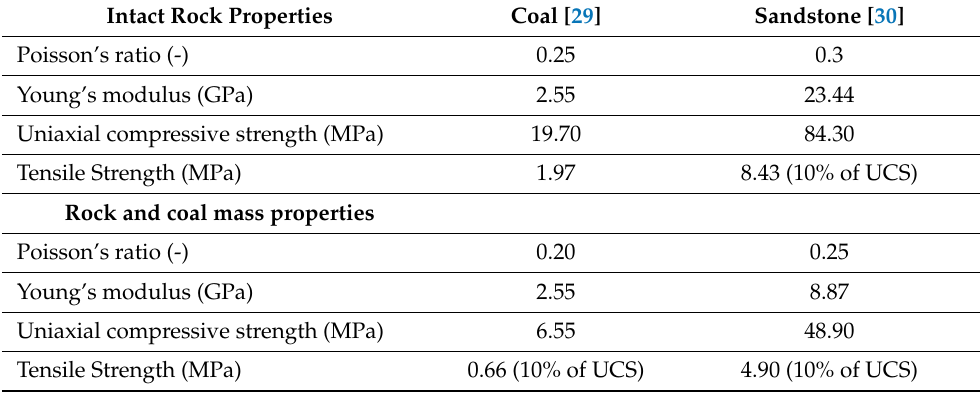
Table 1. Simulation parameters for coal and rock specimens.